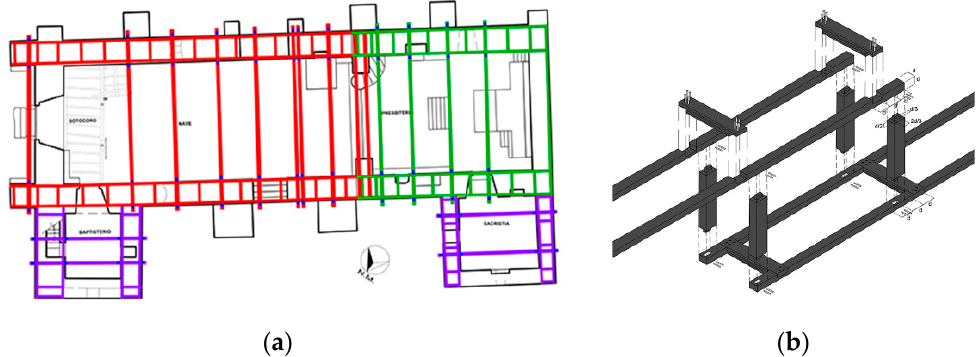
Figure 5. Configuration of the tie beams–bond beams system ( a ) and details of the timber box in the transition of the nave, presbytery and altar lateral walls ( b ).